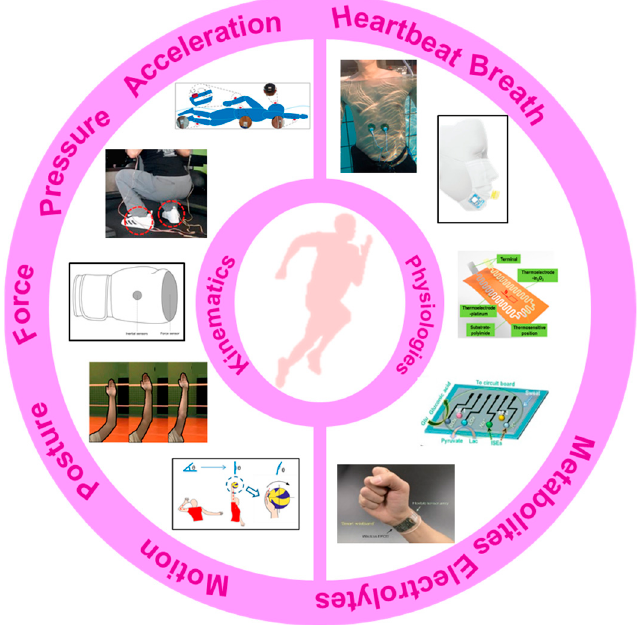
Figure 1. The main concerns of this paper: the monitored indicators and available wearable devices. Reproduced with permissions from [31–35] and under the terms and conditions of the Creative Commons Attribution license of